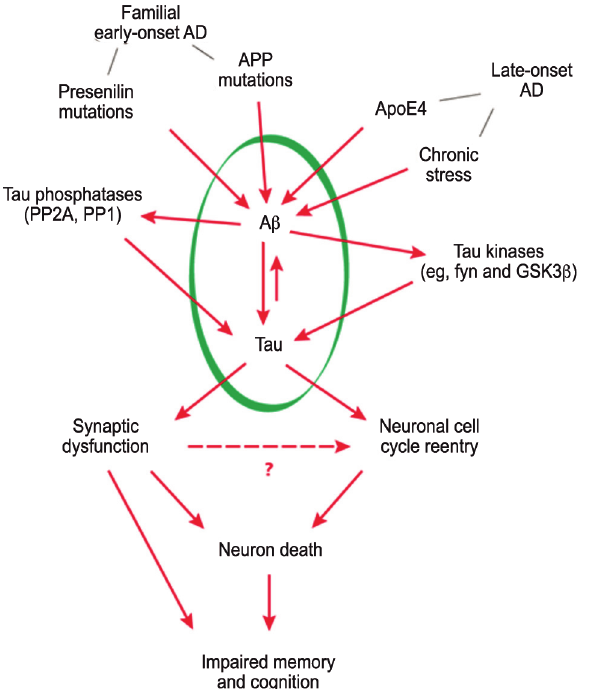
Figure 1. Factors associated with Amyloid-beta peptide accumulation. Chronic stress may constitute another factor that contributes to the ac- cumulation of toxic amyloid beta in late-onset Alzheimer’s disease. Beta- amyloid peptide accumulation promotes the formation of pathological tau tangles that lead to synaptic dysfunction and memory-supporting neuron death, impairing cognitive